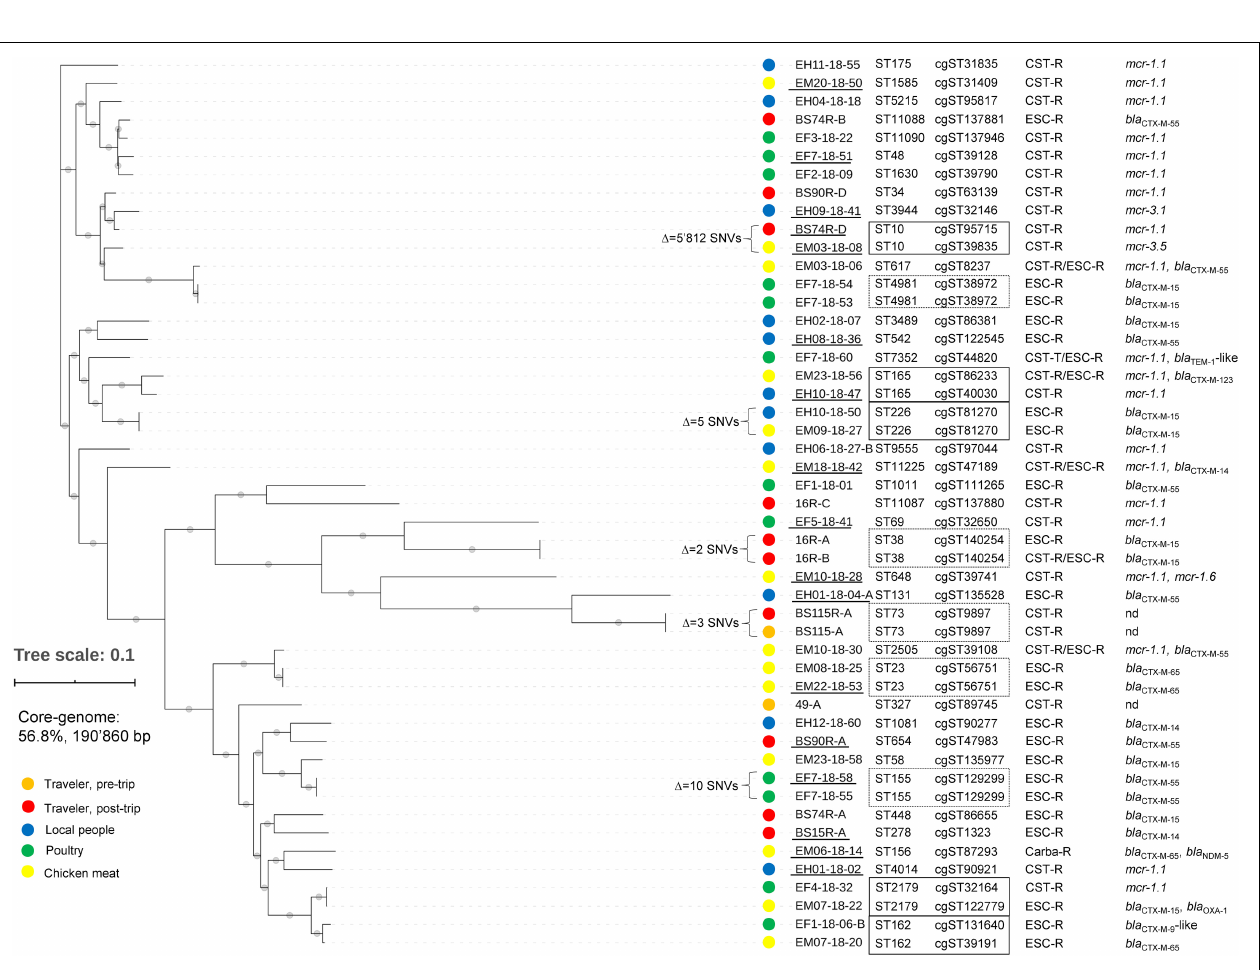
isolate from chicken meat (EM03-18-08), but the two